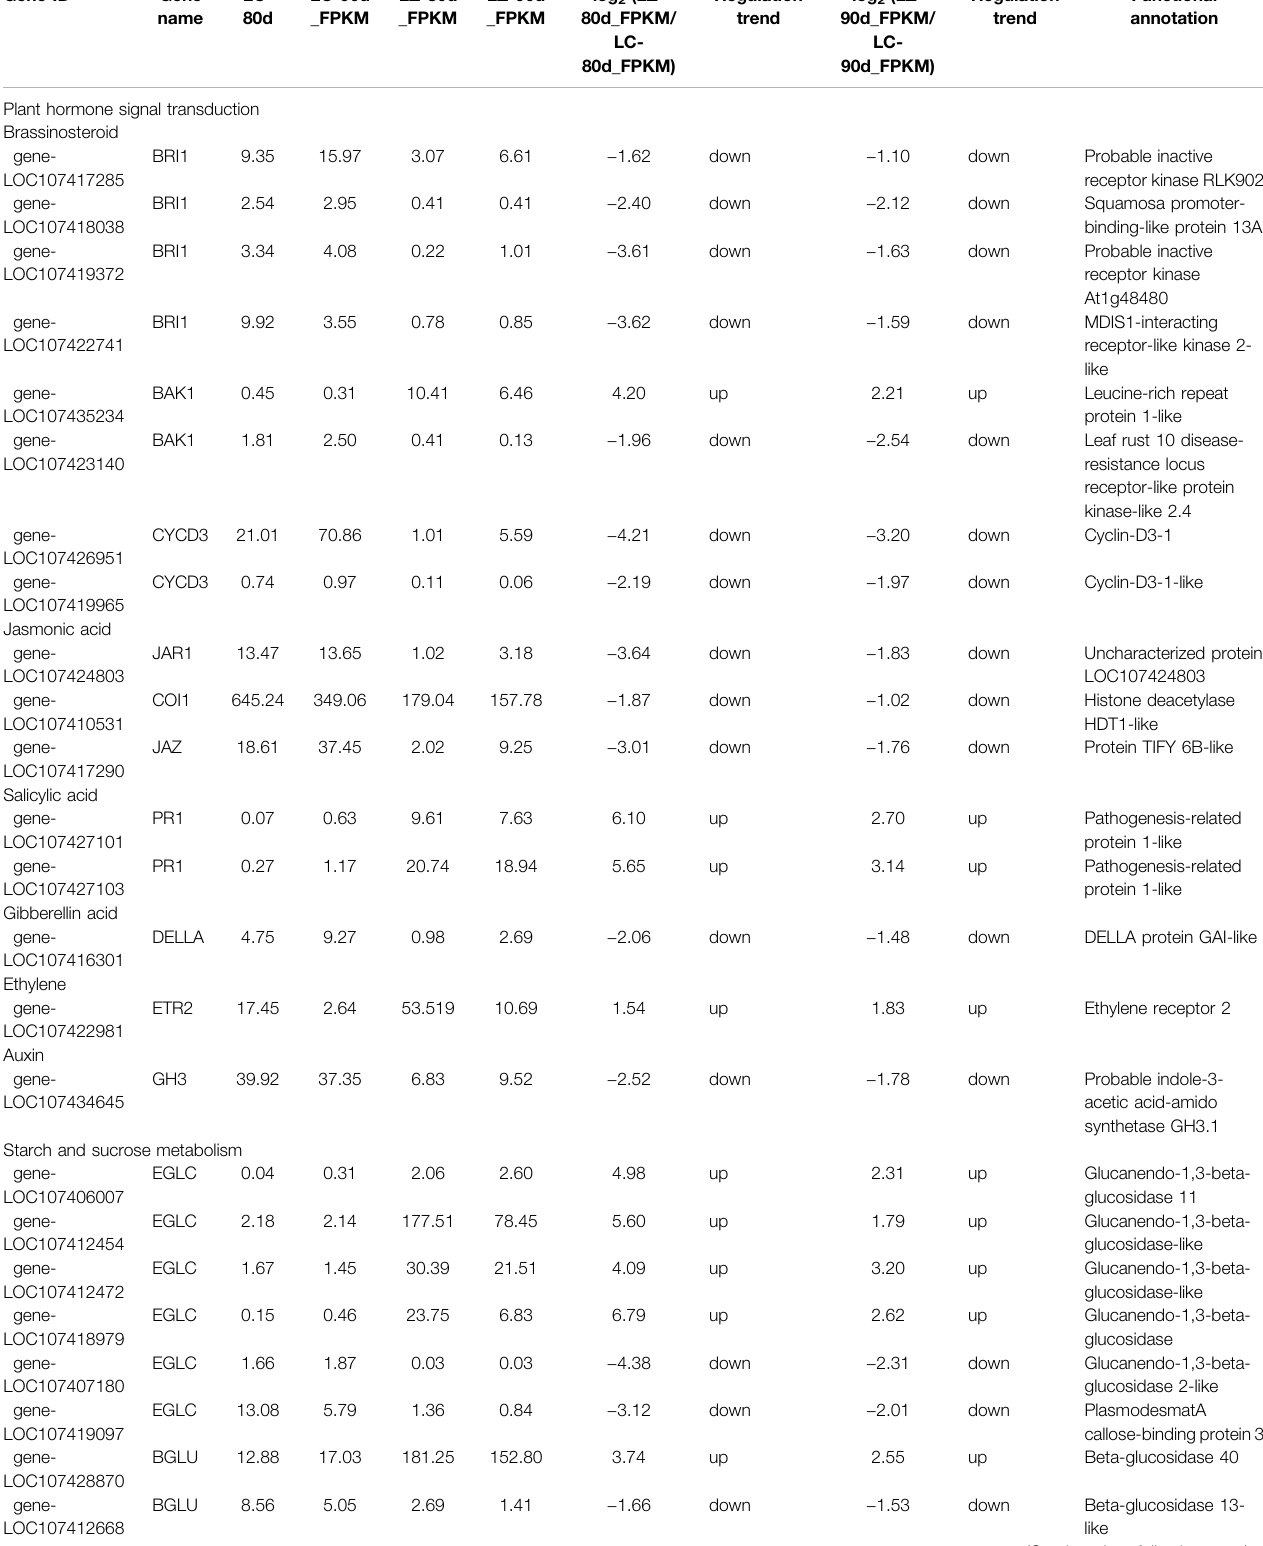
TABLE 3 | DEGs with the annotated functions in plant hormone signal transduction and starch and sucrose